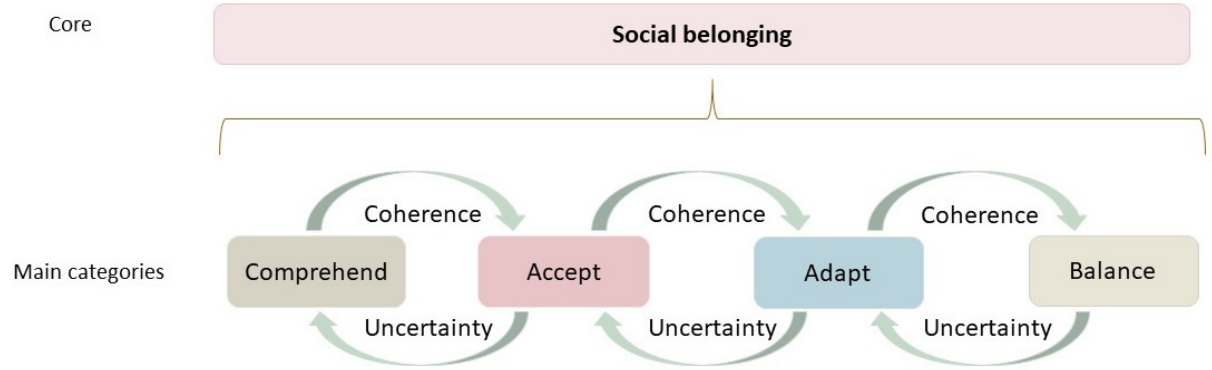
Figure 1. The grounded theory of social belonging among persons diagnosed with Parkinson’s disease.